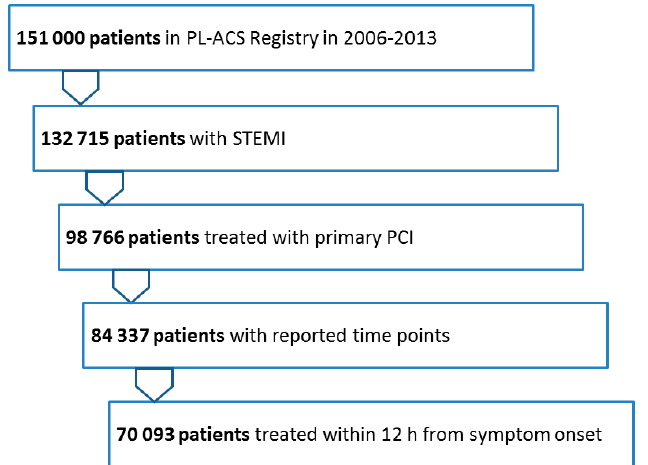
Figure 1. Patient flow. STEMI—ST-segment elevation myocardial infarction, PCI—percutaneous coronary intervention.